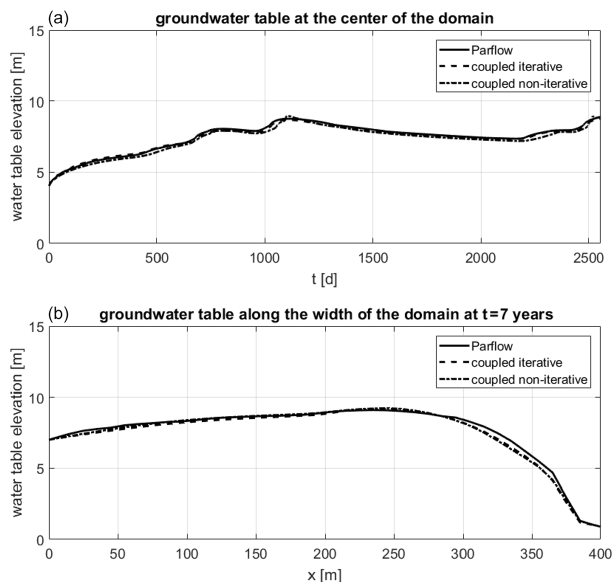
Figure 12. Results of the 3D flow problem. (a) Groundwater table elevation over time in the center of the domain. (b) Groundwater table along the width of the domain ( y = 400m) at the final time